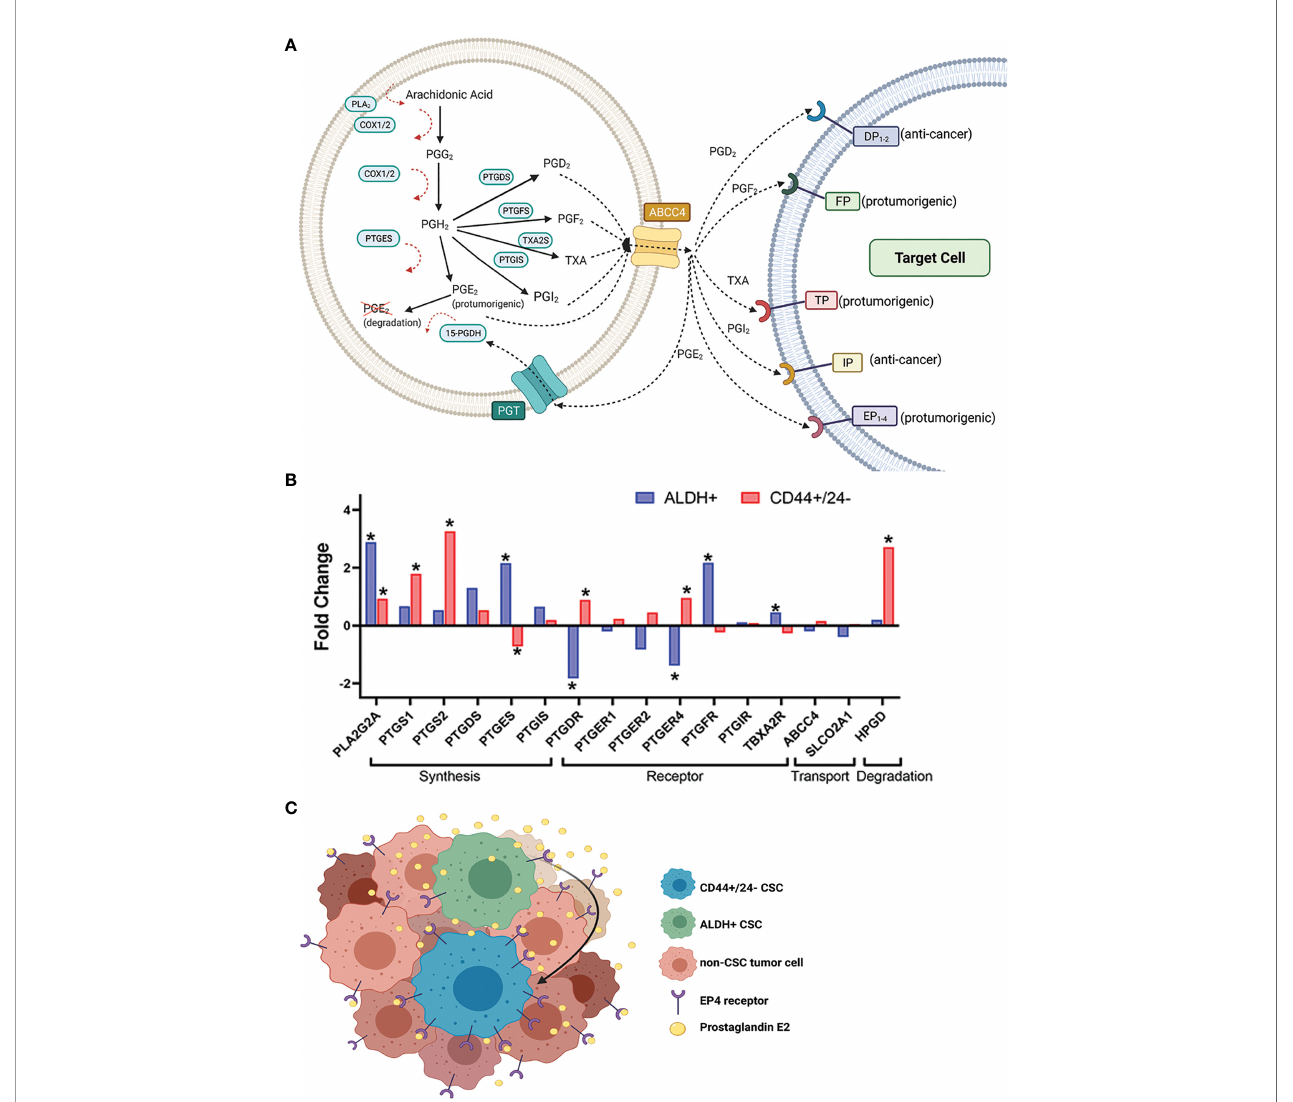
FIGURE 1 | Expression of certain prostaglandin pathway genes in sorted CSC populations from breast cancer patient tumors suggests a hypothetical model for heightened CSC-PGE 2 signaling in breast tumors. (A) Overview of the key players in the synthesis of the prostanoids and subsequent prostaglandin signaling (B) Fold change in expression of the prostaglandin synthesis and signaling genes in breast cancer patient tumor cells sorted for ALDH+ versus ALDH- (GSE52327); or CD44+/CD24- versus non-CD44+/CD24- (GSE5713) cells. Signi fi cance is noted by *, which represents a p-value <0.05. If more than probe was identi fi ed for a gene, the data for the probe with the most signi fi cant fold change is shown. Analyzed genes include phospholipase A ( PLA2G2A ), COX-1 ( PTGS1 ), COX-2 ( PTGS2 ), prostaglandin D synthase ( PTGDS ), prostaglandin E synthase ( PTGES ), prostacyclin synthase ( PTGIS ), DP receptor ( PTGDR ), EP receptors 1, 2,4 ( PTGER1, 2,4 ), FP receptor ( PTGFR ), IP receptor ( PTGIR ), TP receptor ( TBXA2R ), MRP4 ( ABCC4 ), PGT ( SLCO2A1 ), 15-PGDH ( HPGD ). Data for the probes against PTGFS and PTGER3 were missing and so they not included in the analysis. Probe IDs for each of the genes included in the analysis are 243928_s_at ABCC4 ; 203913_s_at HPGD ; 203649_s_at PLA2G2A ; 215894_at PTGDR ; 212187_x_at PTGDS ; 214391_x_at PTGER1 ; 206631_at PTGER2 ; 204897_at PTGER4 ; 207388_s_at PTGES ; 1555097_a_at PTGFR ; 206187_at PTGIR ; 211892_s_at PTGIS ; 205128_x_at PTGS1 ; 204748_at PTGS2 ; 204368_at SLCO2A1 ; 207555_s_at TBXA2R. (C) Hypothetical model based on the data from (B) , where increased PGE 2 signaling in the breast tumor microenvironment results from the interplay between ALDH+ and CD44+/CD24- CSC